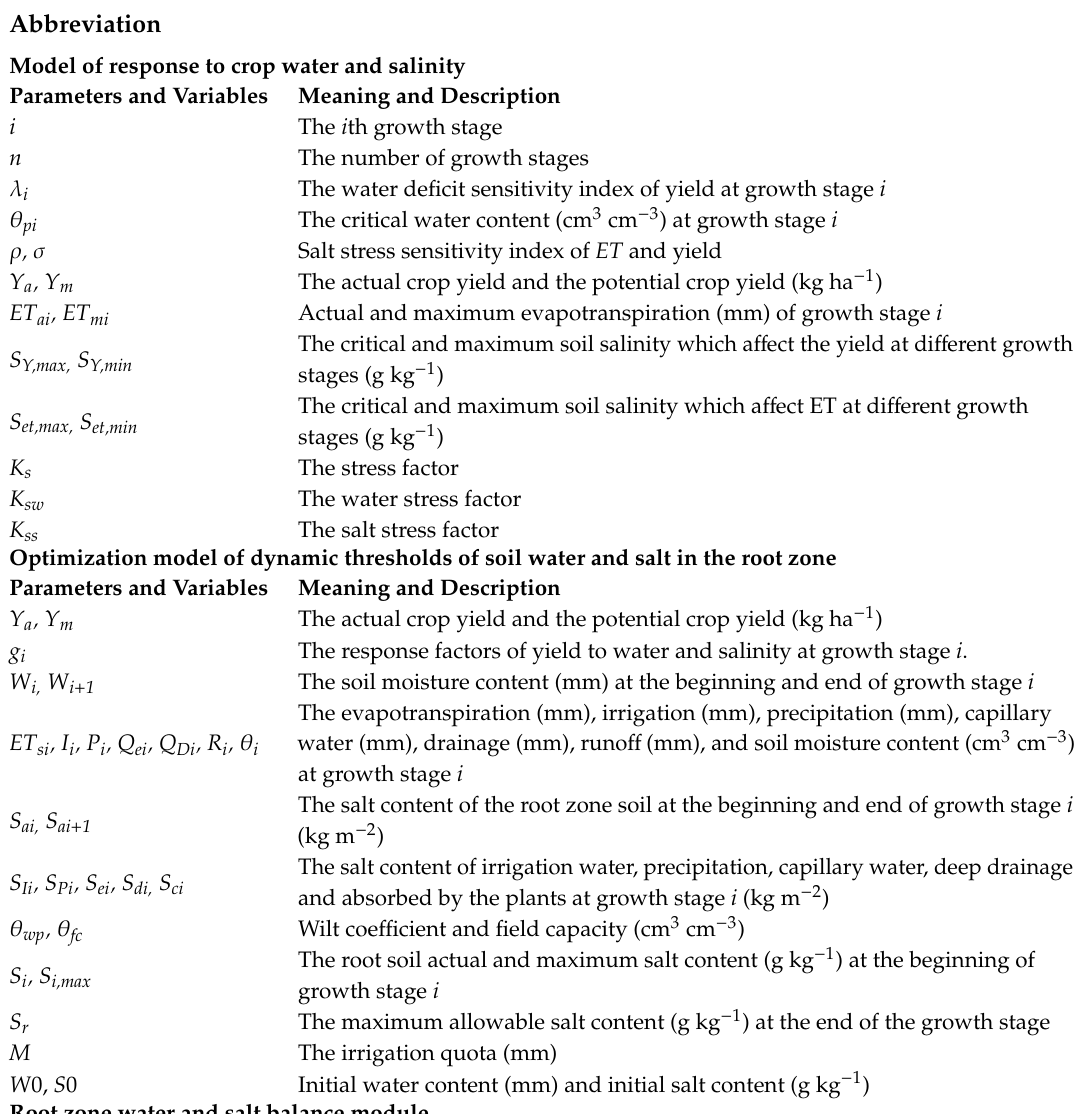
Table S1: Salinity of irrigation water in di ff erent years (g L − 1 ). Table S2: Irrigation schedule of Experiment One. Table S3: Dates of cotton growth stages of Experiment One. Table S4: Dates of cotton growth stages of Experiment Two. Table S5: Irrigation schedule of Experiment Two. Table S6. Data recorded of the two experiment in 2008–2010 and 2018. Figure S1 Daily reference evapotranspiration (ET 0 ) and precipitation during the whole growth period of cotton in Experiment One (a-c) and Experiment Two (d). Figure S2. Soil moisture content of (a) 2008, (b) 2009, (c) 2010 and soil salt content of (d) 2008, (e) 2009 and (f)